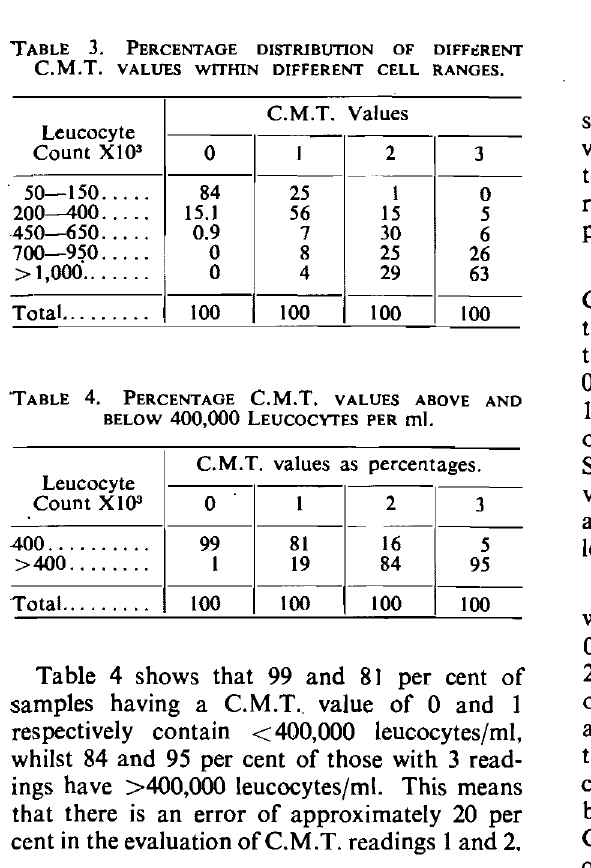
TABLE 5. A COMPARISON BETWEEN A STANDARD C.M.T. SOLUTION AND A . COMMERCIAL PRODUCT. No. of samples/category C.M.T.